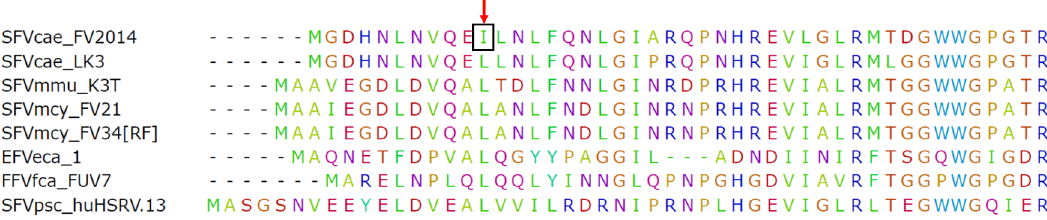
Figure 1. SFVcae_FV2014 variant. Amino acid sequence alignment for N-terminal Gag protein amino acids. The Gag sequences from different foamy viruses (FVs) were aligned using ClustalW. The first 50 amino acids of the alignment are shown. The red arrow points to the position of the conserved leucine in the CC1 domain of Gag; the change to isoleucine is indicated in the box.